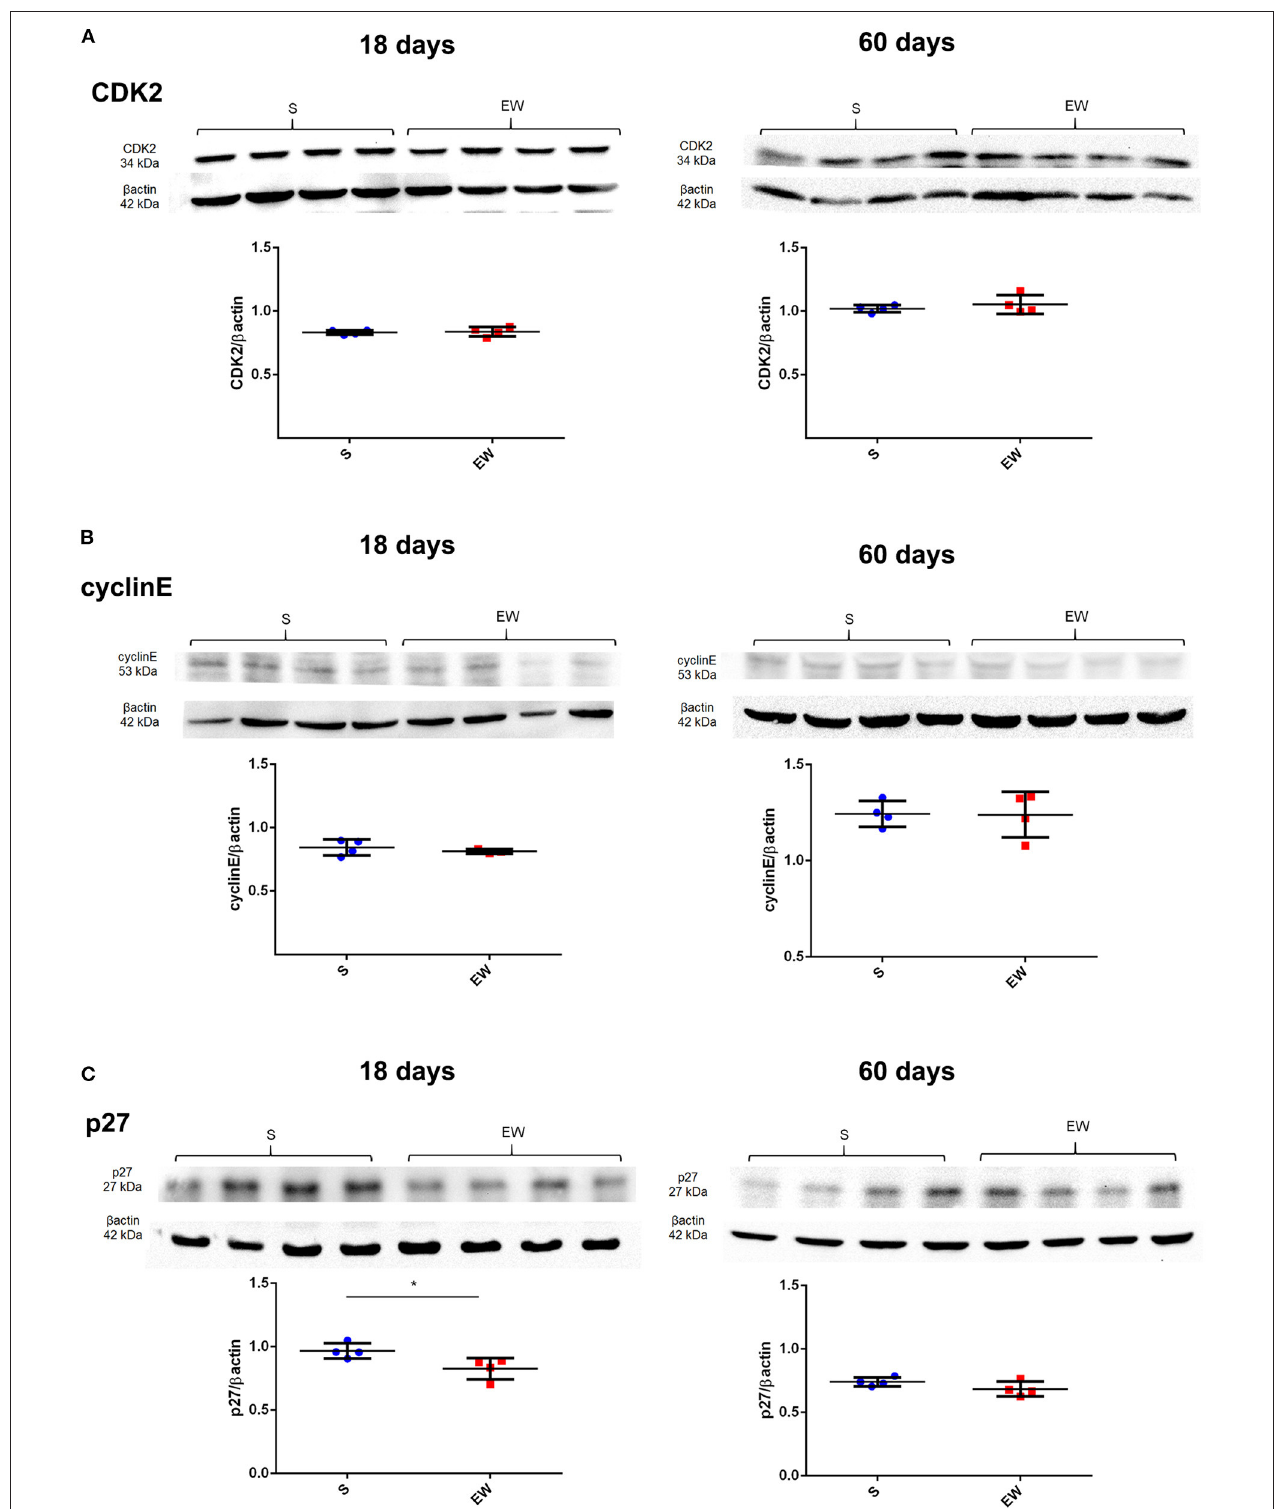
FIGURE 3 | Early weaning effects on cell cycle regulators in the gastric mucosa. (A–C) Representative immunoblots for CDK2 (A) , cyclin E (B) , and p27 (C) and respective β -actin loads (four samples/group). Densitometry was used to compare the integrated optical density (IOD) of each isoform in each sample to β -actin control. Results are represented individually for S (blue) and EW (red) and by means ± SD * p < 0.05 after Student’s t -test.